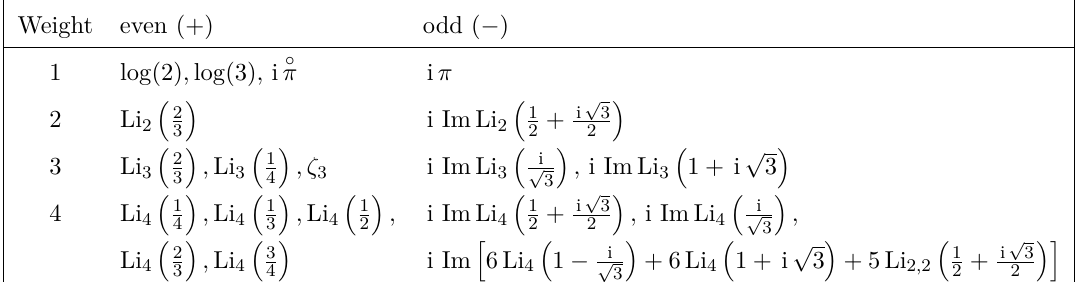
Table 2. The basis S 0 of algebraically independent over Q transcendental constants specifiying the initial values { ~f ( w ) τ,σ ( X 0 ) } at weights w = 0 , 1 , . . . , 4 . The elements of S 0 are charged by Z ≥ 0 representing their transcendental weight, and by Z 2 = { + , −} = { even , odd } representing their parity. We introduced i ◦ π which equals numerically to i π but carries even parity. S ( w, ± ) elements of S 0 with ( w, ± )